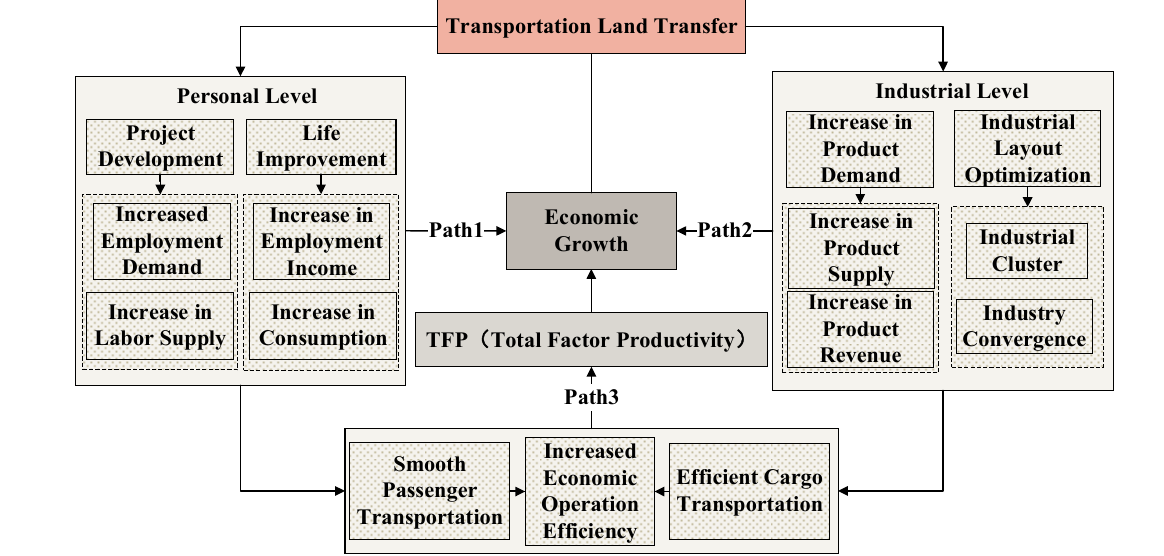
Figure 4. Mediation effect action path. Table 5. Results of the structural equation